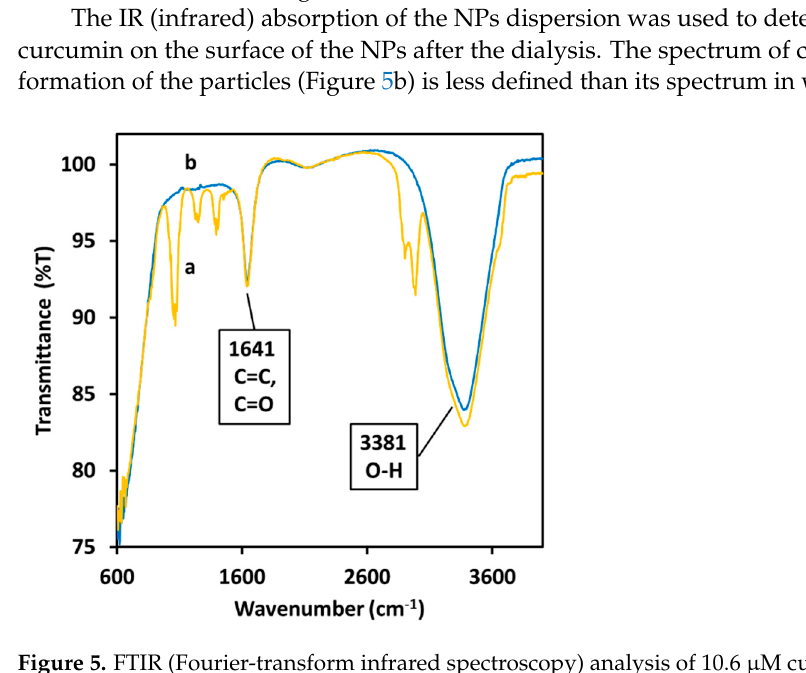
Figure 4. ζ− potential of Cur − AgNPs after dialysis.